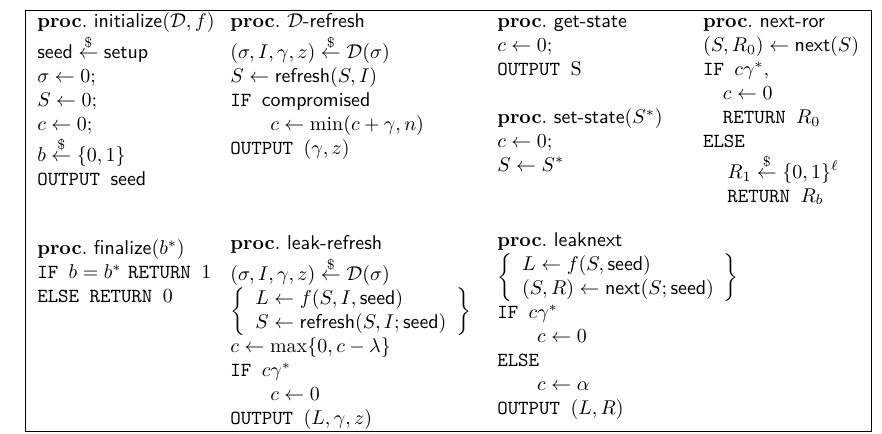
Figure 24: Procedures in the Security Game LROB ( γ ∗ , λ